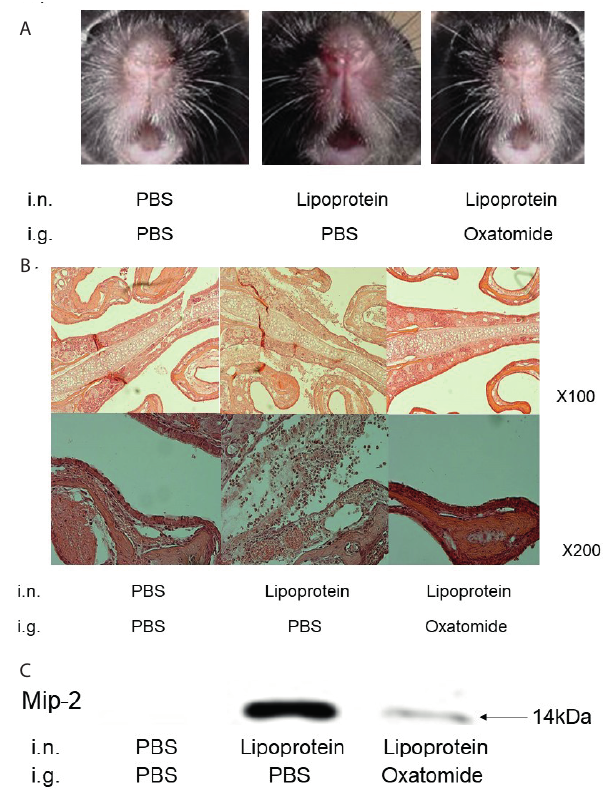
Figure 5. Effects of oxatomide on murine acute rhinitis model. C57BL6 mice were i.n. exposed to lipoprotein for 2 days. A) Photograph of murine face skin around anterior nasal foramen. Left: naive mice. Middle: Lipoprotein exposed mice. Right: Oxatomide-treatment mice exposed with Lipoprotein. B) Nasal membrane tissues of inferior turbinate stained with HE staining method. C) Expression of MIP-2, I k B a and phospho- lylated-I k B a in nasal tissue of mice by western blott assay. Lysate (20 mg) from the nasal membrane were loaded. Data shown represent one of the triplicate